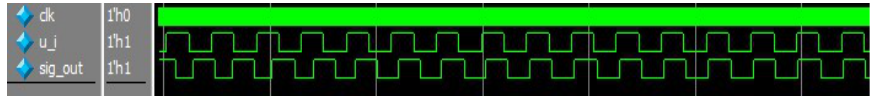
Figure 9. Function simulation diagram of digital phase-locked loop.